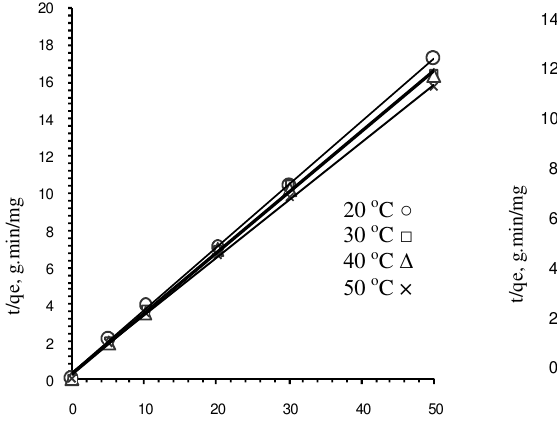
Figure 11. Pseudo-second-order kinetics for the adsorption of Cr(VI), 10 mg/L,onto FMPGP. FMPGP 2 g/L, pH 3 at 16 o C.